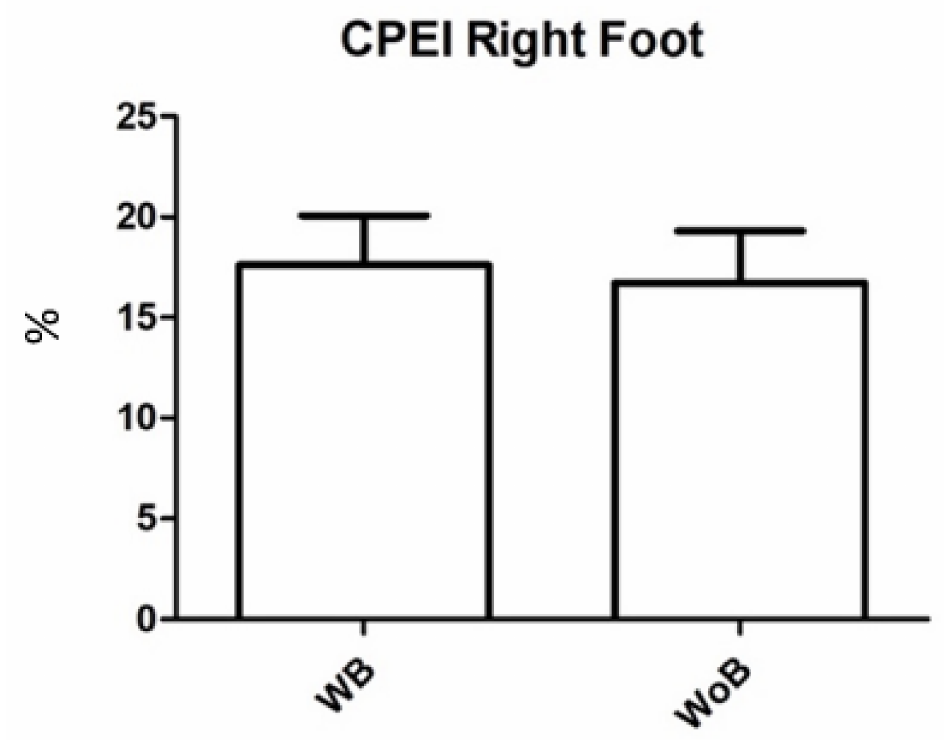
Figure 6. CPEI Right Foot with (WB) and without (WoB)